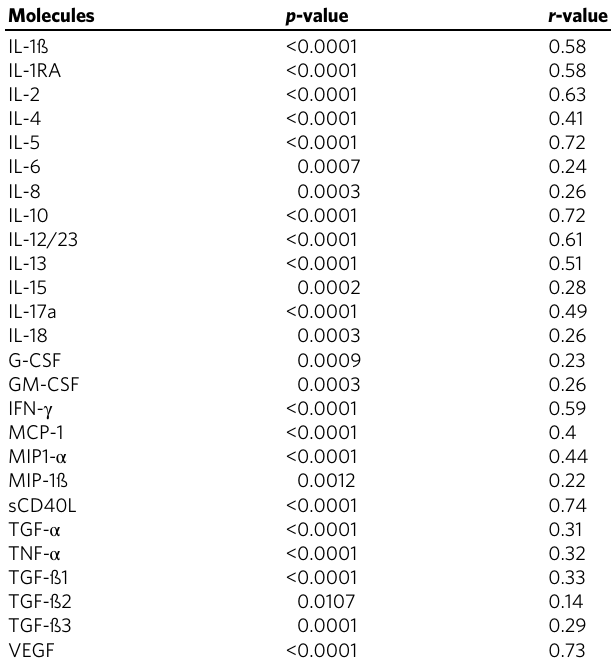
Table 1 Correlations between the level of cytokines and chemokines in seminal plasma and viral replication at day 12